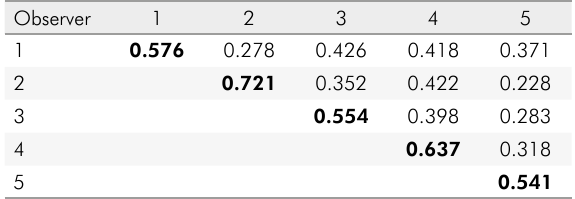
Table 1. Kappa values for intraobserver (in bold) and interobserver agreements (among the 5 observers).